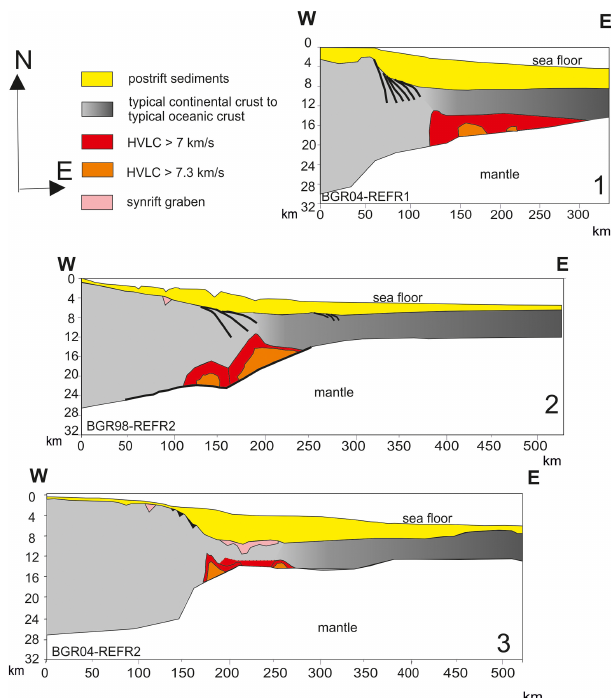
Figure 7. Interpretation of the crustal-scale lines 1–3 from north (top) to south (bottom) along the South American margin with emphasis on the HVLC. HVLC with P -wave velocities above 7.0kms − 1 is indicated in red; HVLC exceeding 7.3kms − 1 is shown in orange. Line 2 is modified after Schnabel et al. (2008). The shape and distribution of SDRs as interpreted from coincident seismic reflection data are indicated as black lines on line 1 and 2.